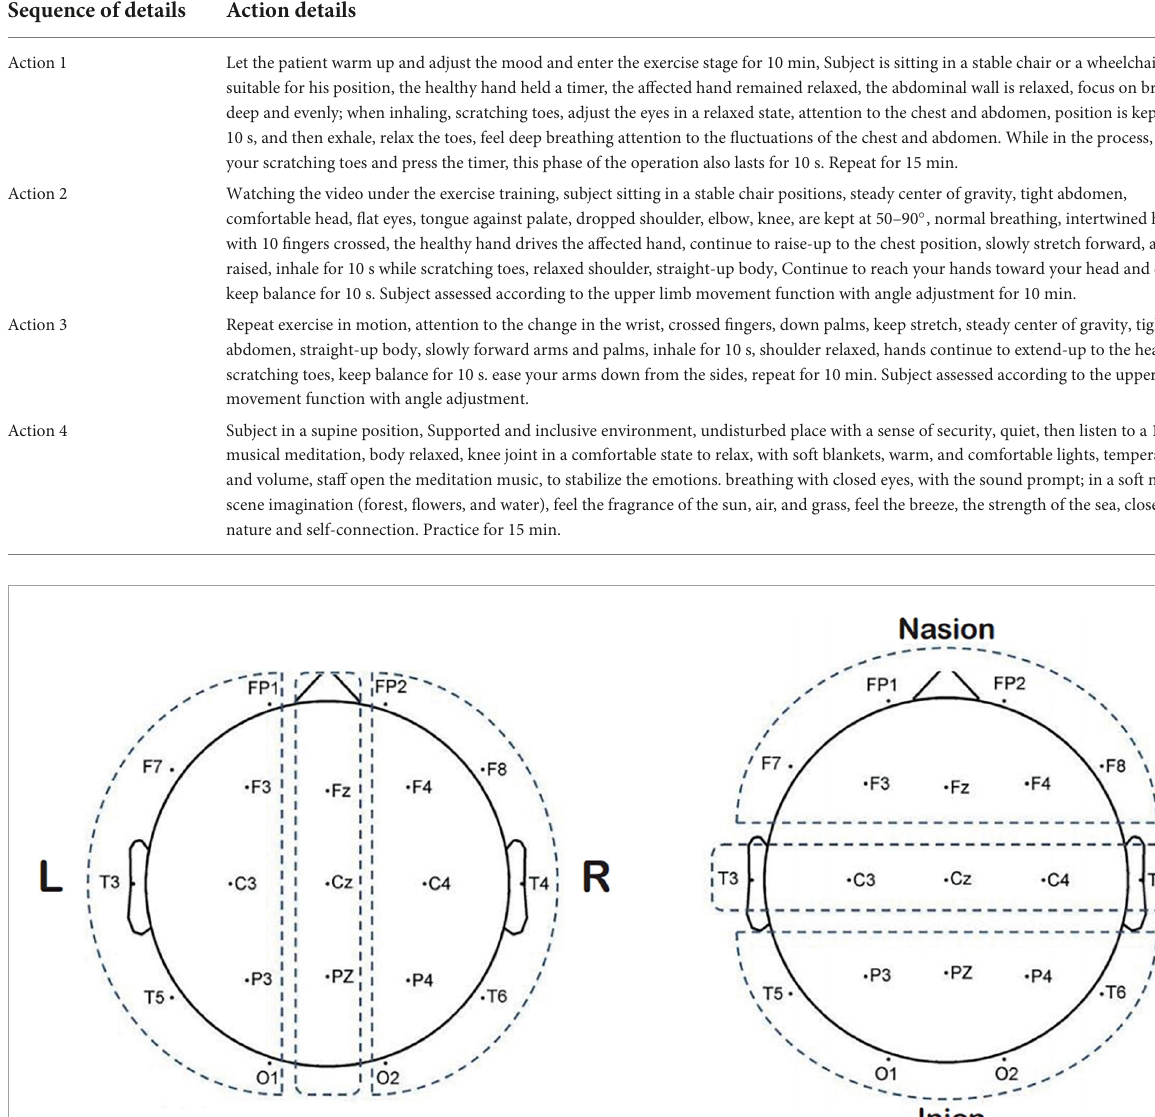
TABLE 1 Details of the operation of Yijinjing Qigong exercise (YJJQE).